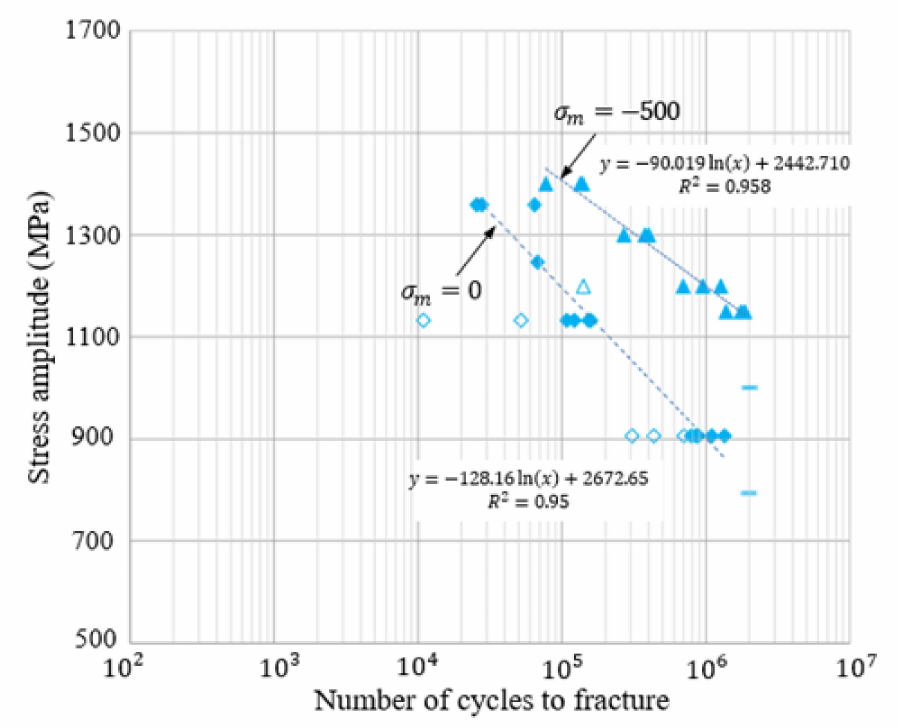
Figure 12. HCF test under zero and negative mean stresses of WC-Co20%. No-fill triangles and diamonds were discarded because of their less reliability in fitting the